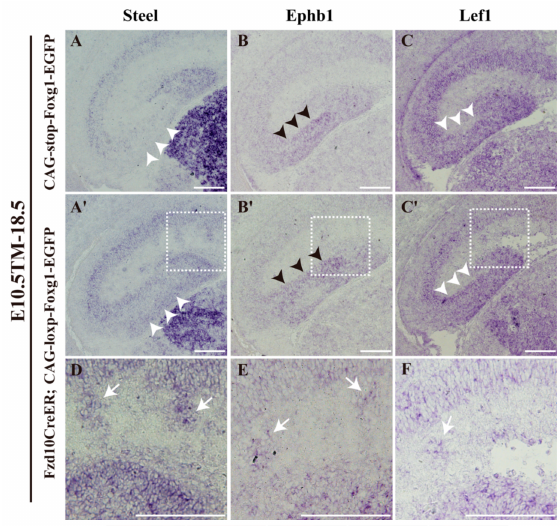
Figure 4. Misdistributed hem-derived cells outside the DG has the property of DG granule neurons. ( A – C (cid:48) ) In situ hybridization assay of Steel ( A , A (cid:48) ), Ephb1 ( B , B (cid:48) ), and Lef1 ( C , C (cid:48) ) on coronal sections of E18.5 CAG-loxp-stop-loxp-Foxg1-IRES-EGFP ( A – C ) and Fzd10CreER TM ;CAG-loxp-Foxg1-IRES-EGFP embryos ( A (cid:48) – C (cid:48) ) showing increased staining for Steel (( A (cid:48) ), white arrowheads) and a little thicker staining for Ephb1 (( B (cid:48) ), black arrowheads) on the migration route. Thicker staining for Lef1 was also observed in the migration route (( C (cid:48) ), white arrowheads). ( D – F ) Magnified views of boxed areas in ( A (cid:48) – C (cid:48) ). Short white arrows indicate the ectopically located clusters. Scale bars: 200 µ